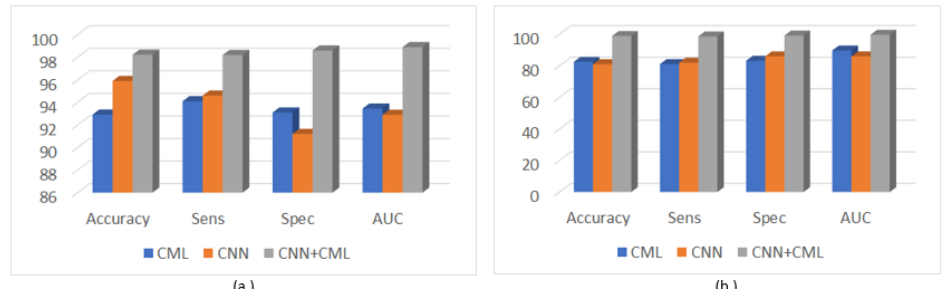
Figure 9. Comparison between the maximum value of the classification performance metrics for the three considered classes of methods: CML, CNN and the combination between CML and CNN (CML+CNN): ( a ) on the GE7 dataset; ( b ) on the GE9